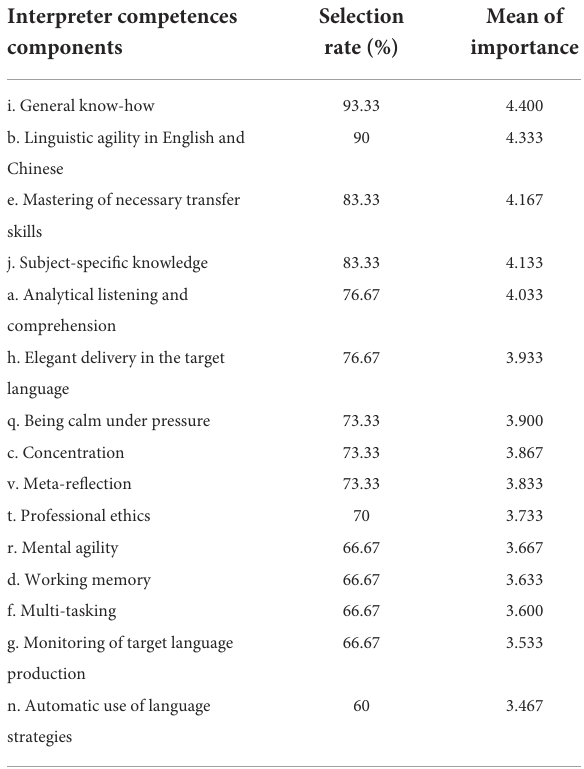
TABLE 7 Frequently selected components that contributed to the development of